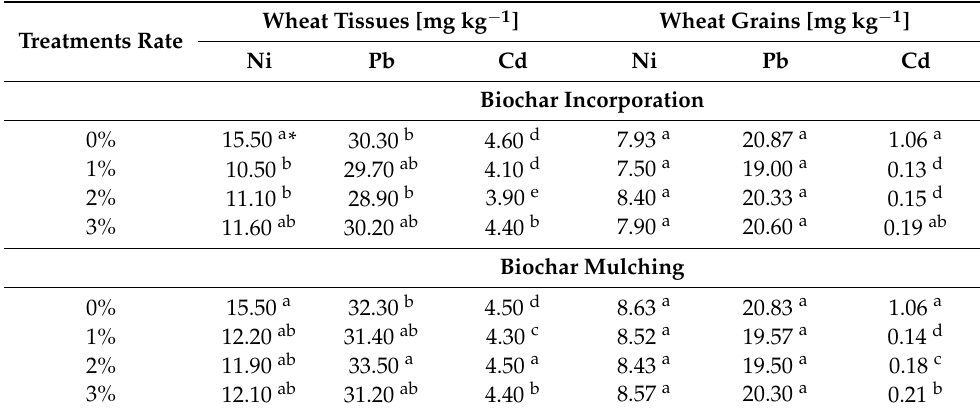
Table 9. Heavy metal concentrations in wheat tissues and grains as affected by biochar and irrigation with Al-Moheet drainage